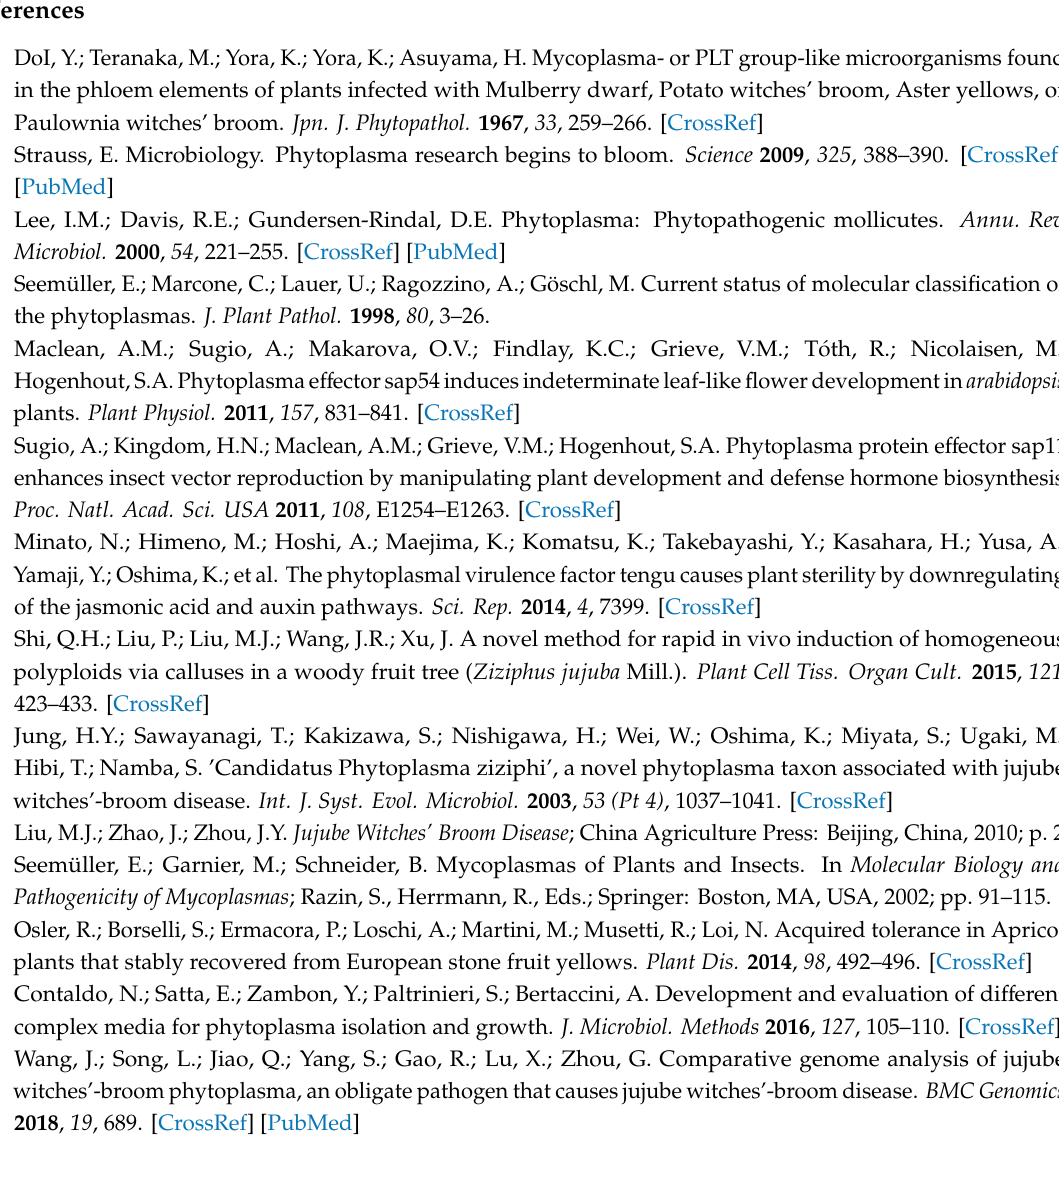
Figure S7: Expression analysis of phytoplasma TMK in susceptible and resistant varieties which were grafted on JWB diseased rootstocks. Table S1: The number of ZjMPK and ZjMKK genes with significant di ff erence expression in JWB-resistant / susceptible cultivars at five stages after phytoplasma